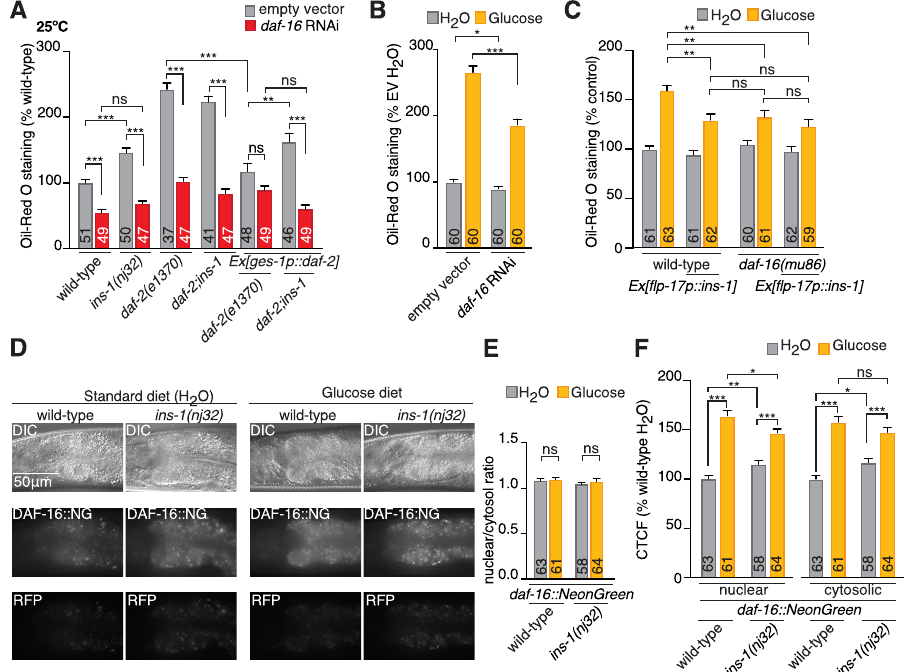
Fig 7. INS-1 action is DAF-16 dependent and modulates intestinal DAF-16 expression. (A) ORO quantification of wild-type, ins-1(nj32) and daf-2(e1370) single mutants, daf-2(e1370); ins-1(nj32) double mutants, daf-1(e1370);Ex[ges- 1p :: daf-2a] lines and daf-2(e1370); ins-1(nj32); Ex[ges-1p :: daf-2a] lines with (red bars) and without (gray bars) daf-16 RNAi treatment. daf-16 RNAi from L1 stage, animals shifted to restrictive temperature 25˚C for 24 hours prior to assaying. (B) ORO quantification of wild-type animals treated with either EV control or RNAi targeted to daf-16 from L1 stage, shifted to HT115 + RNAi + H 2 O (H 2 O) or HT115 + RNAi + 40 mM glucose (Glucose) plates, containing the matching RNAi treatment 24 hours prior to staining. (C) ORO quantification of wild-type and daf-16(mu86) mutants with and without BAG-expressed ins-1cDNA (Ex [flp-17p :: ins-1] ) shifted to OP50 + H 2 O (H 2 O) or OP50 + 40 mM glucose (Glucose) plates 24 hours prior to staining. (D) Representative micrographs of DIC, DAF-16::NeonGreen (DAF-16::NG), and autofluorescence (RFP) in wild-type and ins-1(nj32) mutants shifted to OP50 + H 2 O (H 2 O) or OP50 + 40 mM glucose (Glucose) plates 24 hours prior to imaging. (E) Calculation of nuclear:cytosol DAF-16::NG levels in wild-type and ins-1(nj32) mutants shifted to OP50 + H 2 O (H 2 O) or OP50 + 40 mM glucose (Glucose) plates 24 hours prior to imaging. (F) Quantification of normalized cellular fluorescence levels (CTCF) of DAF-16::NG in the nuclei and cytosol of wild-type and ins-1(nj32) mutants shifted to OP50 + H 2 O (H 2 O) or OP50 + 40 mM glucose (Glucose) plates 24 hours prior to imaging. All data presented as � x + SEM, n shown in bar. A–C and E and F significance assessed by mixed-effects model (2-way ANOVA). ns, not significant ( p > 0.05), � = p � 0.05, �� = p � 0.01, ��� = p � 0.001. The underlying numerical data can be found in S1 Data. CTCF, calculated total fluorescence; EV, empty vector; ORO, Oil-Red O; RFP, red fluorescent protein; RNAi, RNA